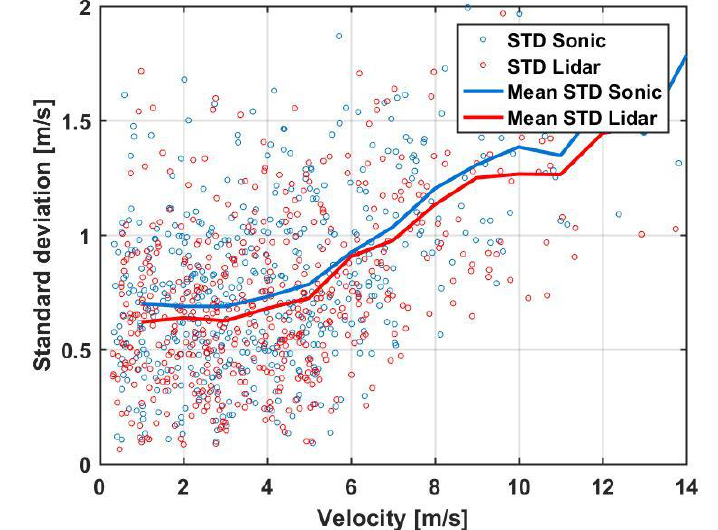
Figure 11. Ten-minute mean turbulence intensity versus velocity for the Lidar and the sonic